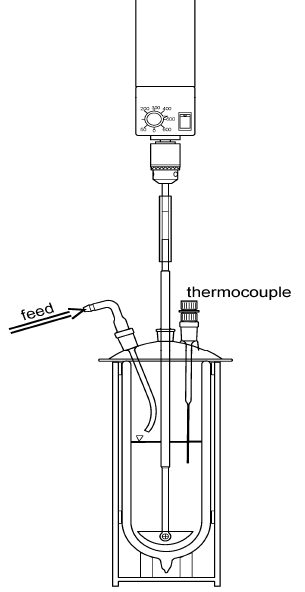
Figure 2. Dewar reactor—Set up for macroscopic reaction heat analysis.